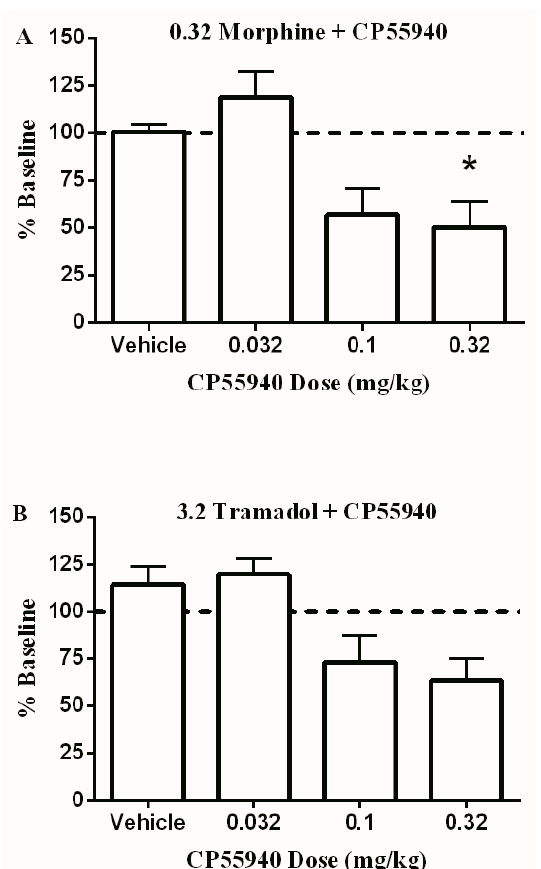
Figure 4. The e ff ect of di ff erent doses of CP55940 on ICSS in combination with 0.32 mg / kg morphine Figure 4. The effect of different doses of CP55940 on ICSS in combination with 0.32 mg/kg morphine ( A ) or 3.2 mg / kg tramadol ( B ). Abscissae: dose of CP55940. Ordinates: percent baseline ( A ) or 3.2 mg/kg tramadol ( B ). Abscissae: dose of CP55940. Ordinates: percent baseline stimulations